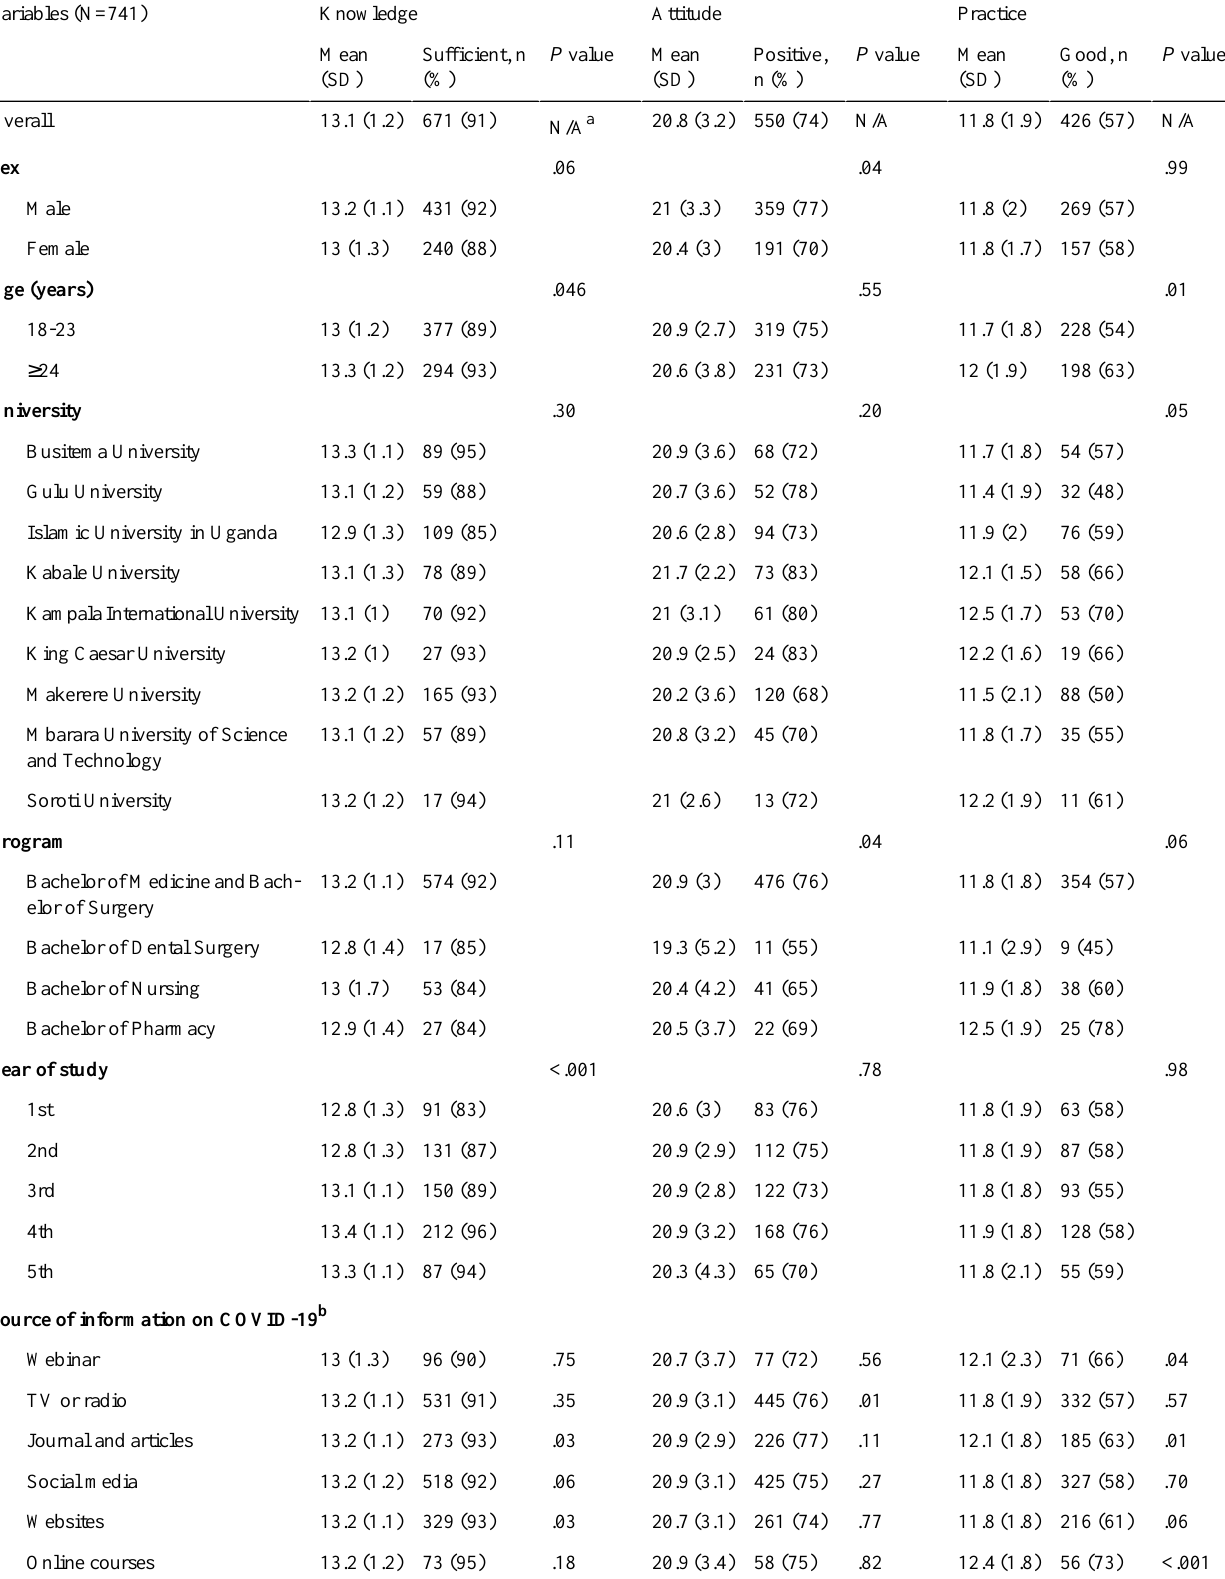
Table 3. Mean scores and chi-square test showing knowledge, attitude, and practices of medical students in Uganda toward COVID-19. PracticeAttitudeKnowledgeVariables